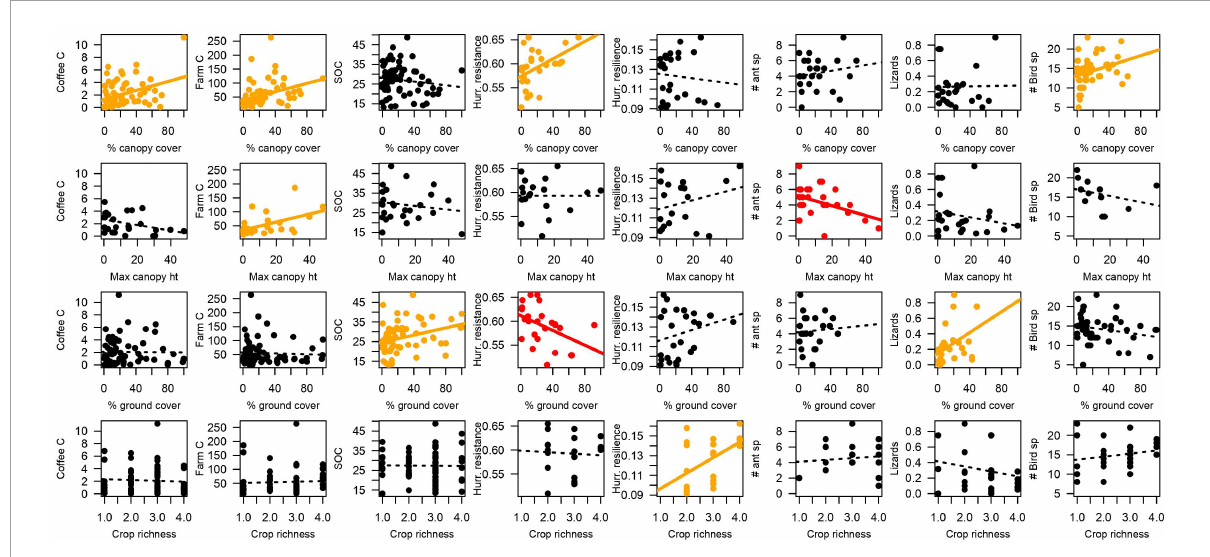
FIGURE6 Scatter plots for all of the management effects on ecosystem service and biodiversity conservation studied. Black indicates a non-significant relationship, red indicates a negative significant relationship, and yellow indicates a positive significant relationship ( p <